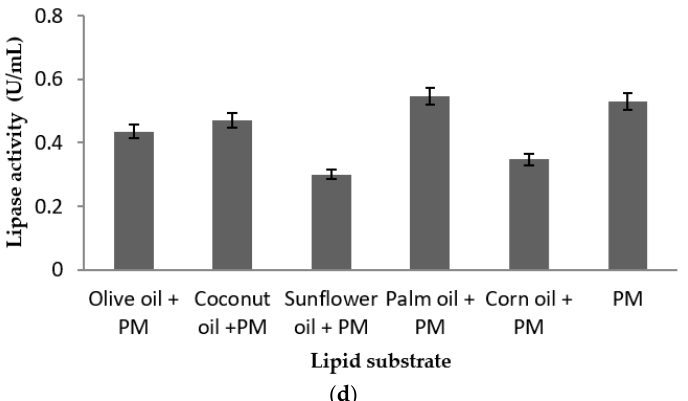
Figure 5. Lipase activities represented by mean value ± standard deviation (n = 3). ( a ) Influence of carbon source on lipase activity of strain LSK25. Carbon sources were added to the media to a final concentration of 1% ( w / v ). ( b ) Influence of nitrogen source on lipase activity of strain LSK25. The nitrogen sources were added to a final concentration of 0.8% ( w / v ). ( c ) Influence of various metal ions on lipase activity of strain LSK25. The metal ions in nitrate form were added to a final concentration of 1 mM. ( d ) Influence of various natural triglycerides on lipase activity of strain LSK25. Olive oil in production medium was substituted with the other substrates to a concentration of 1% ( v / v ) (PM = Production medium).